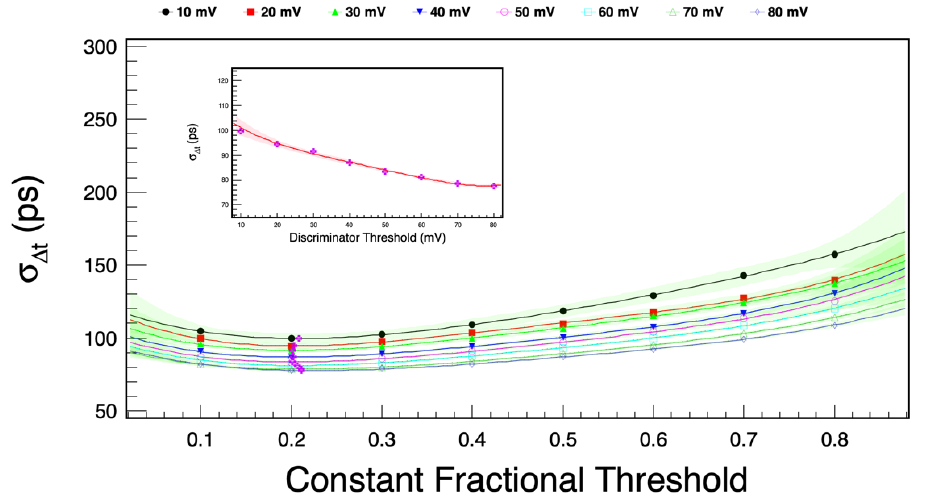
Figure 12. CTR as a function of the constant fractional threshold for different discriminator thresh- olds that are proportional to the electron energy. The minimum CTR values (magenta points) are distributed around a constant fractional threshold of 0.2 (20%). The inlay shows the minimum CTR as a function of the discriminator threshold. The CTR gradually improves with increasing electron energy from ( 98 ± 0.4 ) ps to ( 78 ± 0.3 ) ps. The colored error bands indicate the 95% confidence level of the